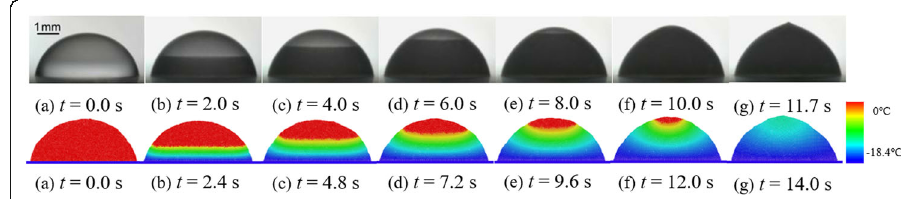
Fig. 3 The process of freezing 20 ul of supercooled water droplets on a cold plate at a temperature of − 18.4 °C (experimental and